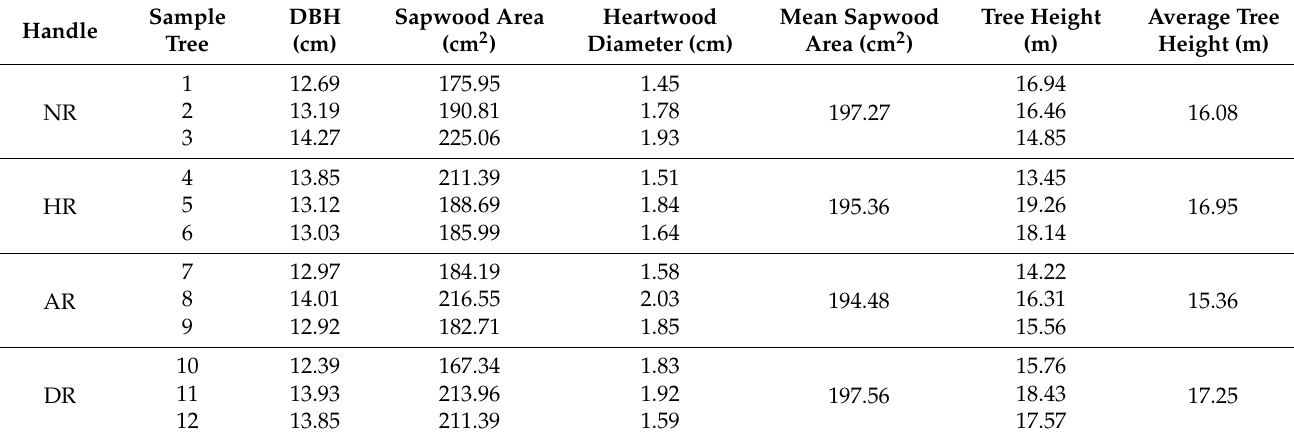
Table 1. Determination of sample wood information of P. orientalis by sap